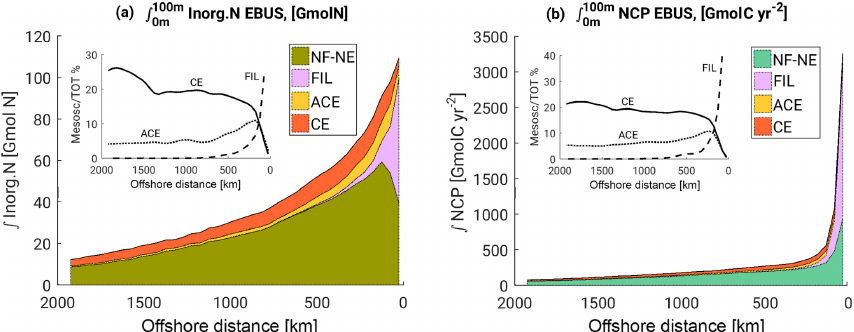
Figure B8. Inorganic nitrogen (Inorg.N) and net community production (NCP) contained at different distances from the coast in filaments (FIL), cyclonic eddies (CE), anticyclonic eddies (ACE) and outside of the mesoscale structures (non-filament-non-eddy, NF-NE). Both quantities are integrated in the first 100m depth and across the horizontal extension of the CanUS. Inserts: percentage of the total Inorg.N and NCP found within ACE, CE and FIL, by offshore distance; the FIL share of Inorg.N and NCP in the first 50km offshore is not plotted as their contribution in this range cannot be clearly identified.